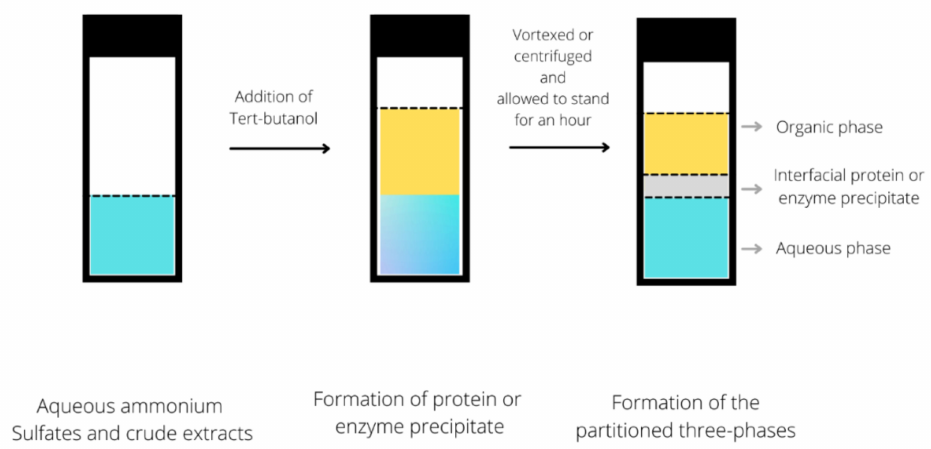
Figure 2. Schematic diagram of a three-phase partitioning